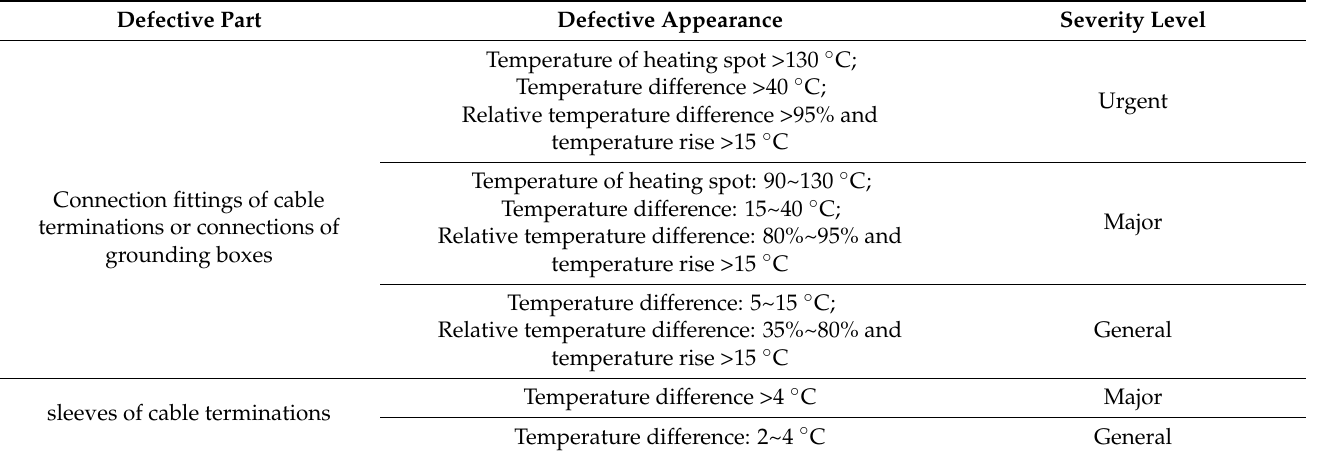
Table 2. Diagnostic standard for HV cable accessories.